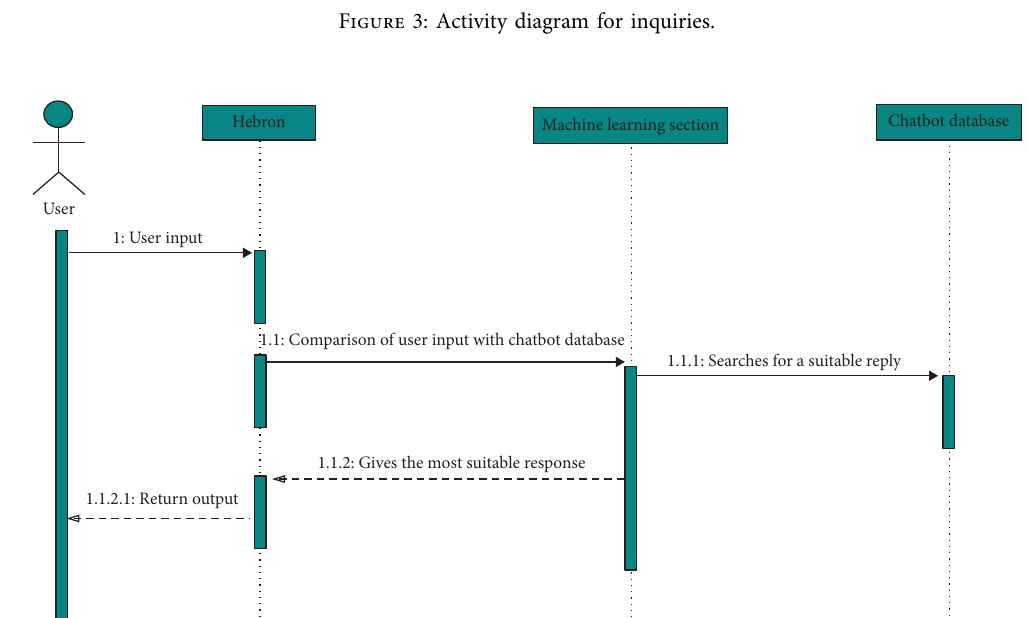
Figure 3: Activity diagram for inquiries.